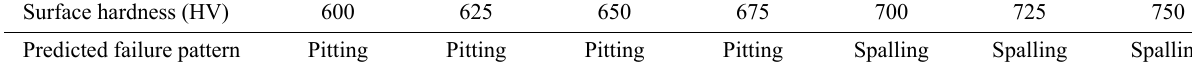
Table 3 Failure modes with different surface hardness. Surface hardness